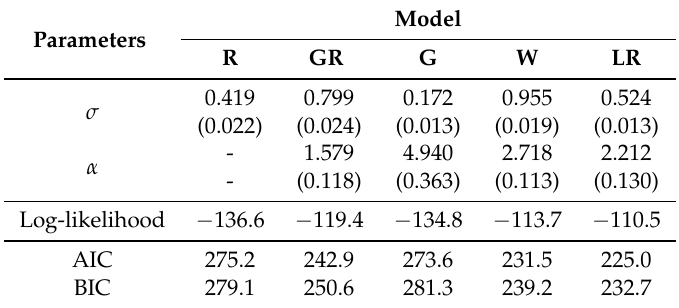
Table 6. Parameter estimates (standard errors) and maximum values of the log-likelihood functions of the R, GR, G, W and LR models fitted to the nicotine measurements